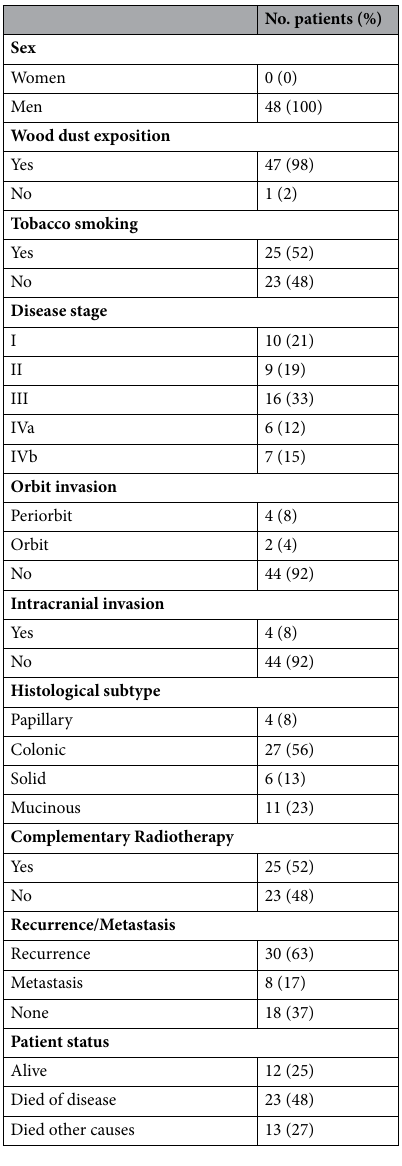
Table 1. Clinical features of 48